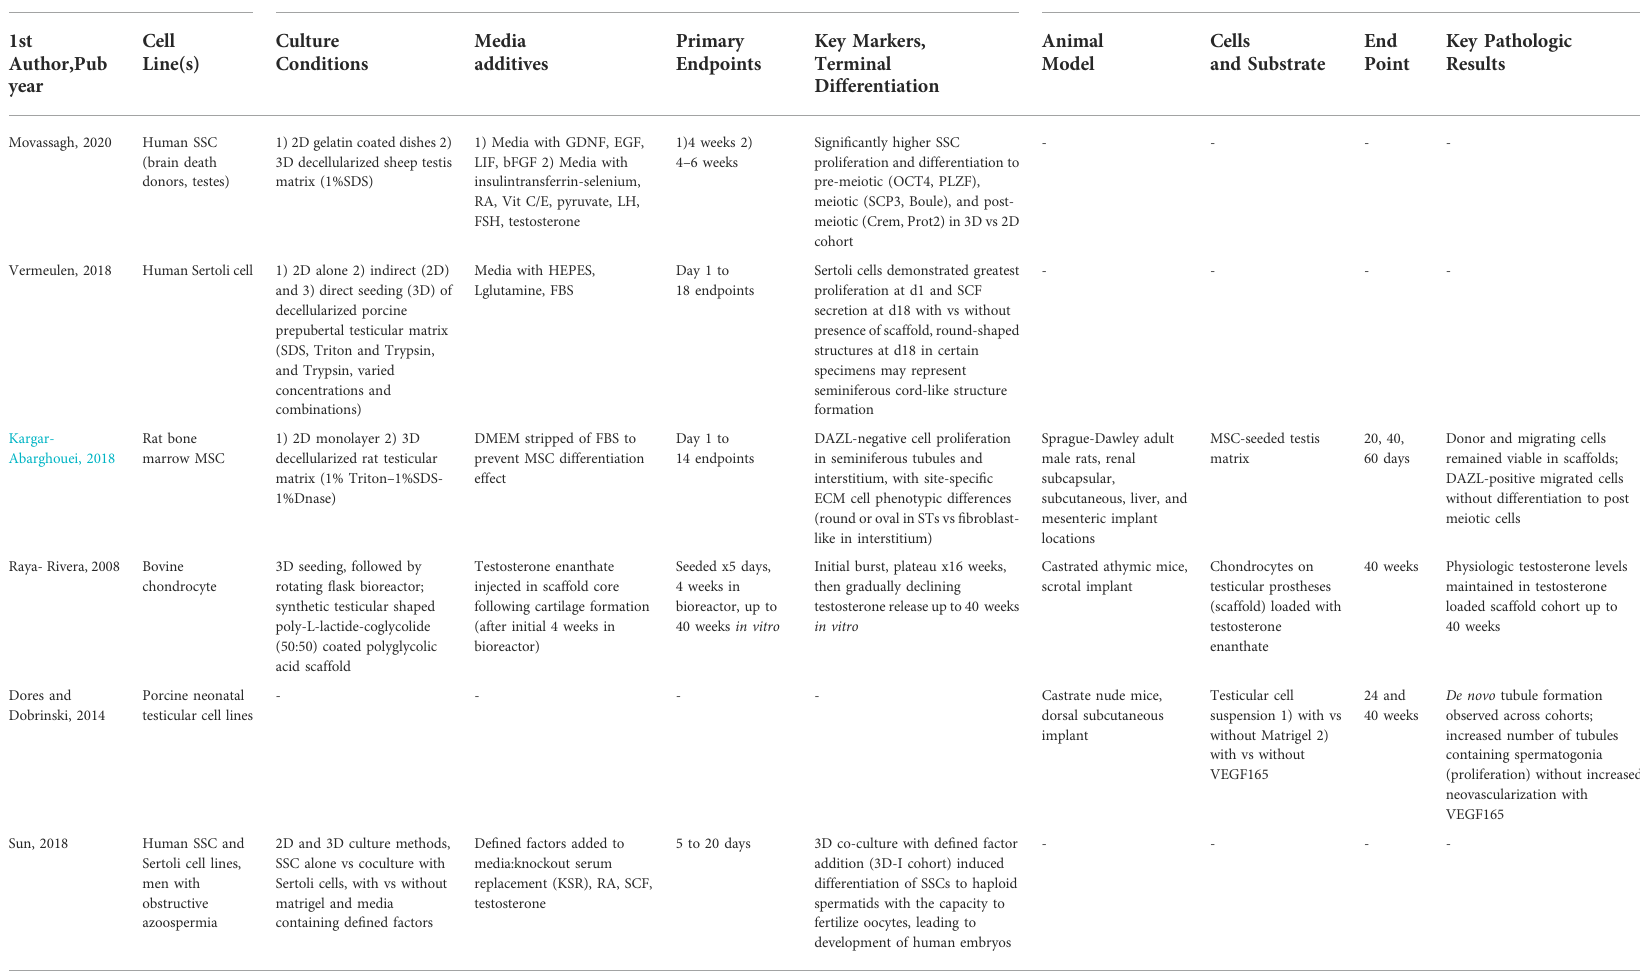
TABLE 2 Studies evaluating methods to recreate the testicular